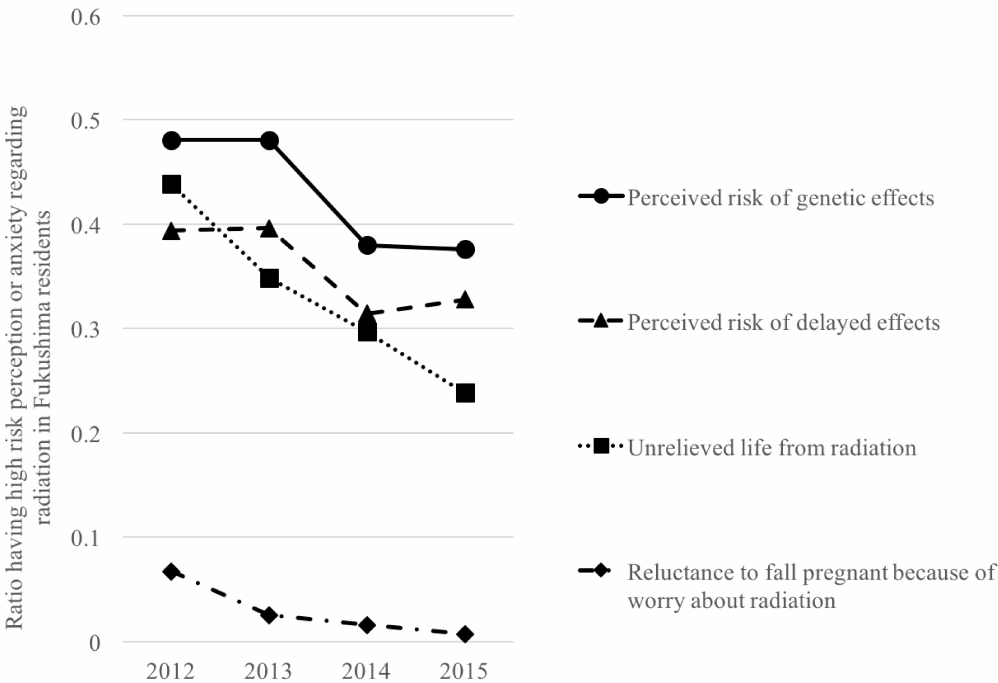
Figure 2. Change in ratios of high anxiety or risk perception regarding radiation over time in Fukushima residents [35,36].